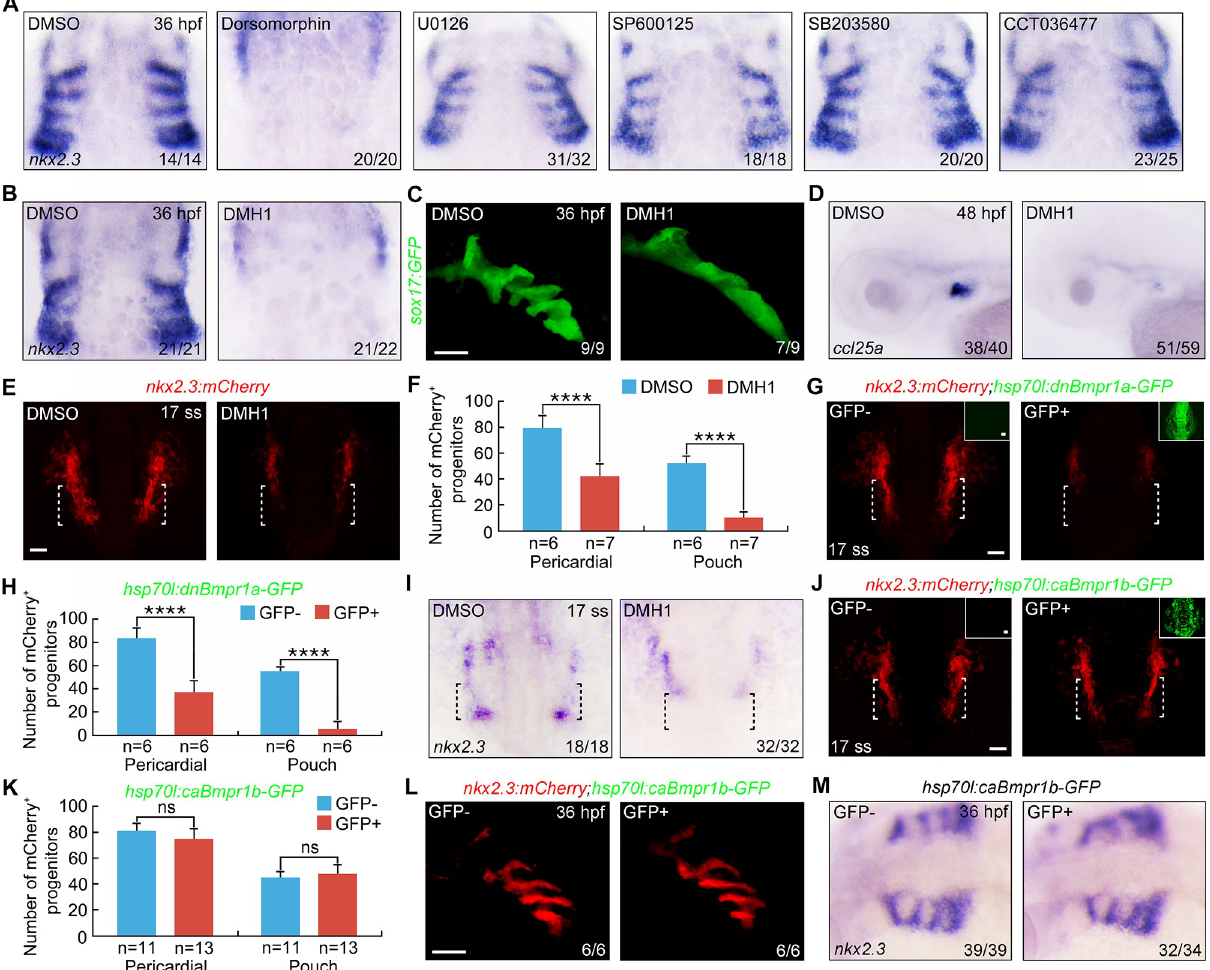
Fig 3. BMP signal inactivation leads to a decrease of pouch progenitors. ( A-B ) Wild-type embryos were exposed to different inhibitors from bud stage to the 17-somite stage and harvested at 36 hpf for i n situ hybridizations with nkx2 . 3 probe. Dorsal views, anterior to the top. Note that embryos treated with 20 μ M Dorsomorphin (A) or 10 μ M DMH1 (B) showed a clear reduction of nkx2 . 3 expression in pharyngeal pouches. ( C ) Live confocal images of malformed pharyngeal pouches in 10 μ M DMH1 treated Tg(sox17 : GFP) embryos at 36 hpf. Scale bar, 50 μ m. ( D ) In situ hybridization of thymus marker ccl25a in DMH1 treated embryos at 48 hpf. Lateral views, anterior to the left. ( E-F ) Representative confocal sections showing mCherry + progenitors in embryos treated with or without 10 μ M DMH1 from bud stage to the 17-somite stage (E). The lateral pharyngeal endoderm is indicated by white dotted lines. Scale bar, 50 μ m. Quantification of the numbers of pericardial and pouch progenitors positive for mCherry in DMSO and DMH1 conditions was shown in (F). The group values are expressed as mean ± s.d. Student’s t-test, ���� P < 0.0001. ( G-H ) mCherry fluorescence in 9 hpf-heat shocked Tg(nkx2 . 3 : mCherry;hsp70l : dnBmpr1a-GFP) embryos at the 17-somite stage (G). Scale bar, 50 μ m. The numbers of mCherry+ progenitors were quantified from heat shocked-embryos with or without GFP expression (H). Student’s t -test, ���� P < 0.0001. ( I ) The expression of nkx2 . 3 in embryos treated with 10 μ M DMH1 from bud stage to the 17-somite stage. Black dotted lines indicate the region where the pouch progenitors are located. ( J-M ) Overactivation of BMP signaling has no effect on the formation of nkx2 . 3 + pouch progenitors and pouch epithelium. Tg(nkx2 . 3 : mCherry;hsp70l : caBmpr1b-GFP) embryos were heat shocked at 9 hpf for 20 min, and then harvested at the indicated developmental stages for in vivo confocal imaging (J-L) and in situ hybridization (M). Scale bars, 50 μ m. The number of mCherry + progenitors was calculated from heat shocked-embryos in (J) and presented in (K). ns,